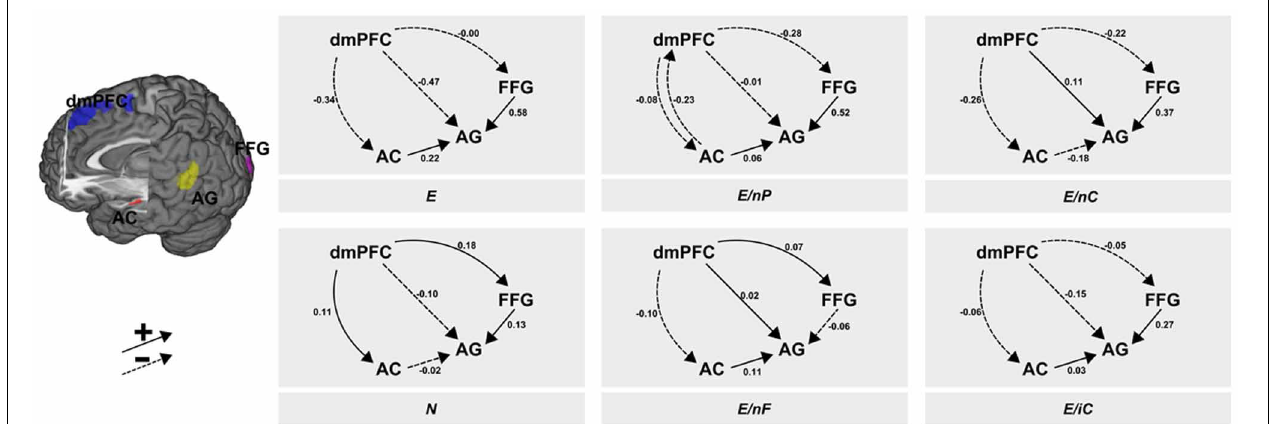
FIGURE 3 | Results of the DCM analysis. The six panels show the modulatory inputs of the six different conditions on the connections between the regions. The stimuli conveyed neutral or emotional information via facial expressions, prosody and speech content. These channels were either consistent [all neutral (N) or all emotional (E)] or one of the three channels